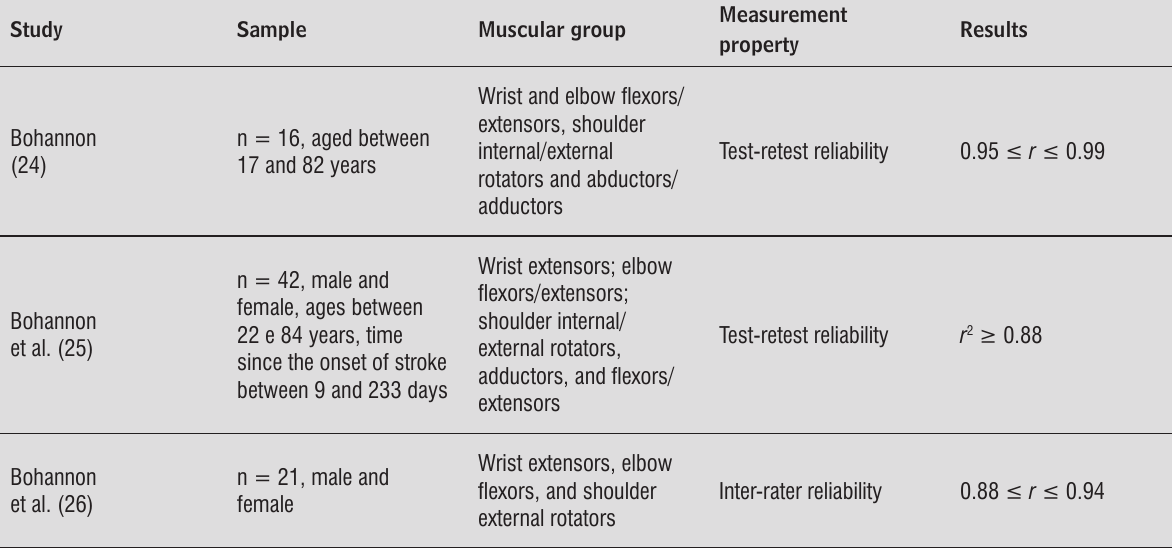
Table 5 - Results of the nine studies which assessed the measurement properties of the portable